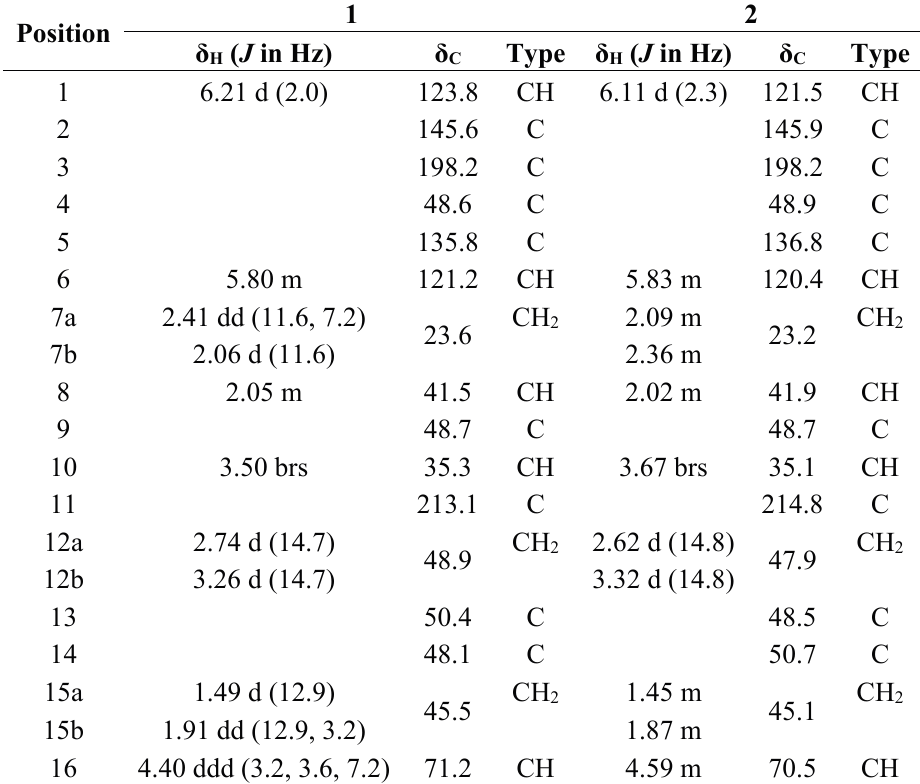
Figure 2. Key COSY (thick bonds), HMBC (solid arrows) and NOESY (dashed arrows) correlations of compounds 1 and 2 . Table 1. 1 H- and 13 C-NMR spectroscopic data for 6 ′ -acetyl-2- O - β - D -glucocucurbitacin E ( 1 ) (500 MHz, CDCl 3 ) and 25- p -coumaroyl-3 ′ -acetyl-2- O - β - D -glucocucurbitacin I ( 2 ) (400 MHz, CD 3